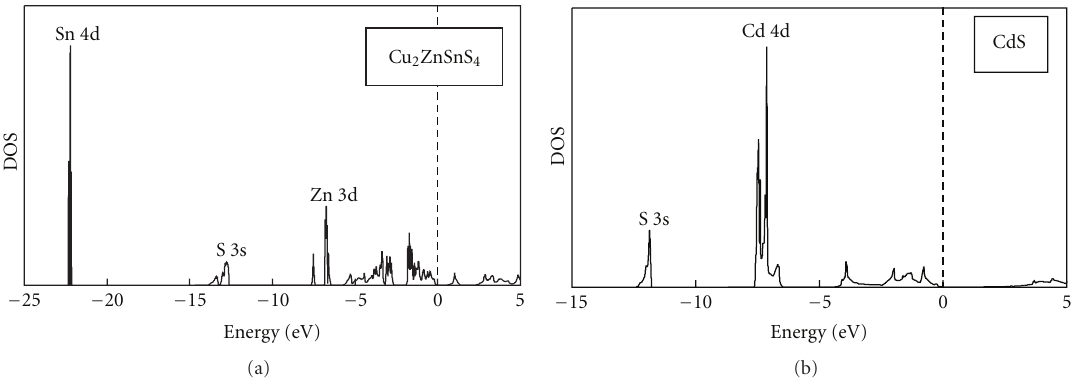
Figure 2: Density of states for (a) Cu 2 ZnSnS 4 and (b) CdS.